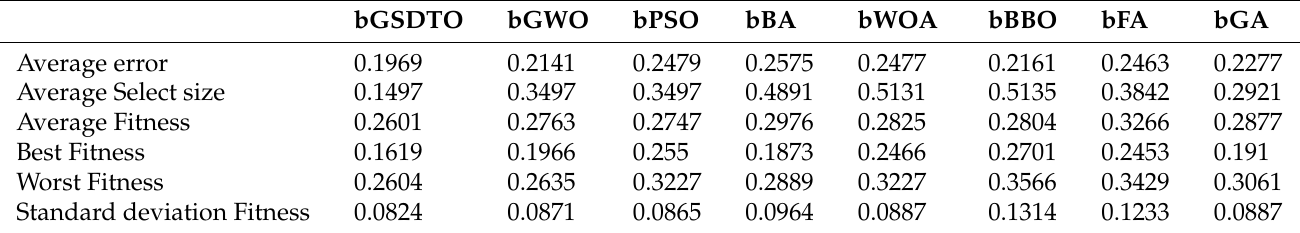
Table 6. Presented bGSDTO and compared algorithms feature selection